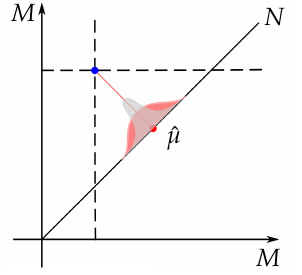
Figure 2. The mean estimator viewed as a projection onto the diagonal of a product manifold. Conditioning on the closest point in the diagonal yields a density on the diagonal depending on the time to arrival T > 0. As T tends to zero the density convergence to the Dirac-delta distribution (grey), whereas as T increases the variance of the distribution increases